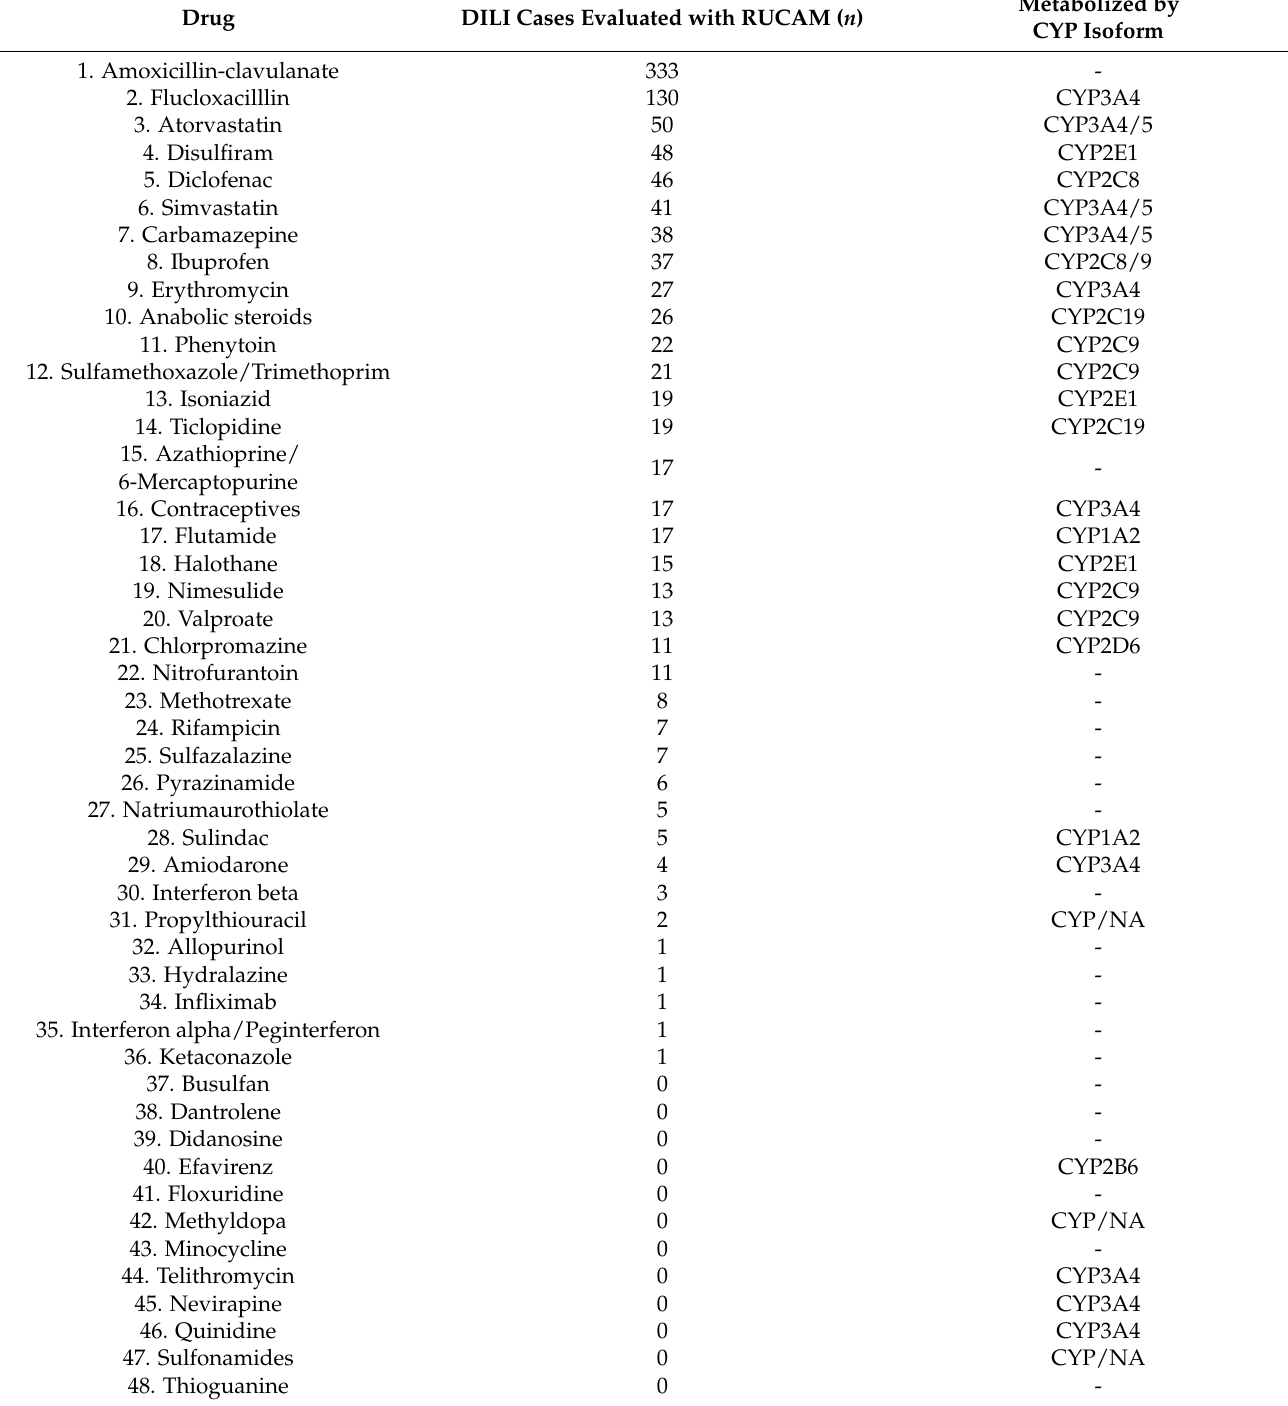
Table 2. Involvement of hepatic microsomal CYP isoforms in idiosyncratic DILI caused by various drugs as evaluated with